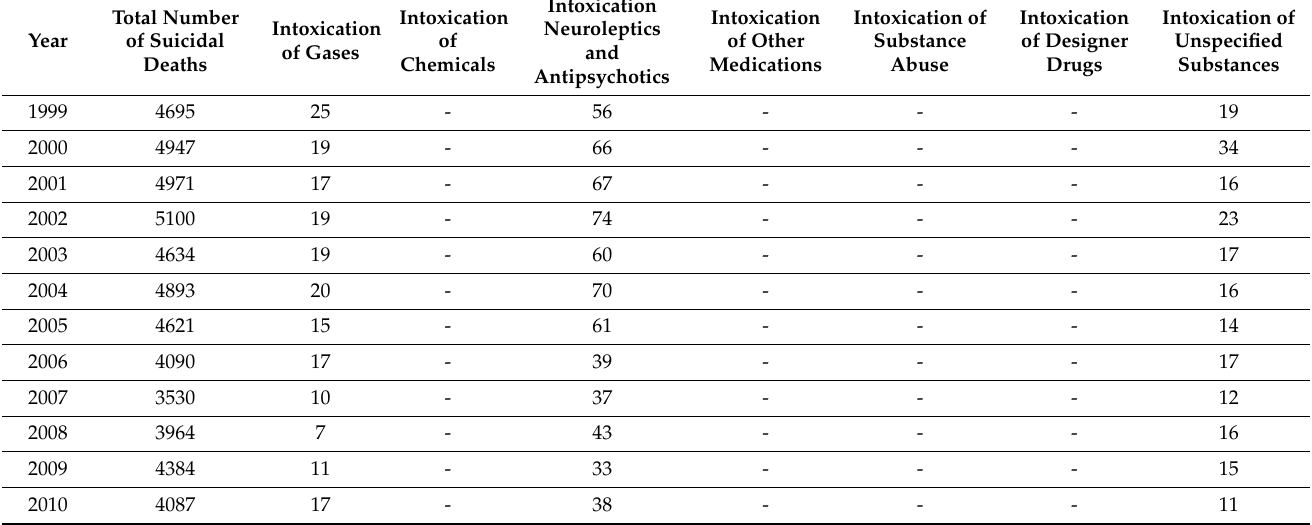
Table 2. Suicidal deaths by substance in 1999–2020 in Poland (source: own study based on data by